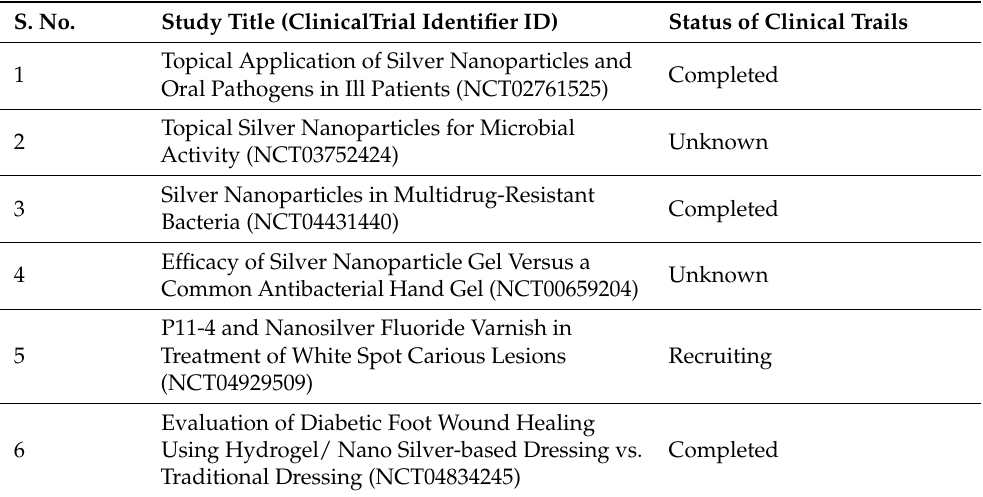
Table 5. Clinical transformation status of some silver nanoparticles-based